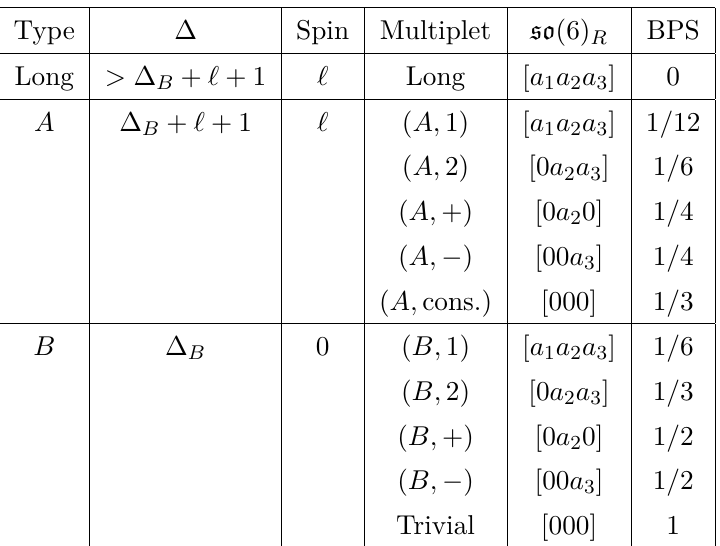
Table 2 . Multiplets of osp (6 | 4) and the quantum numbers of their superconformal primary, where ∆ B = a 1 + 1 ( a 2 + a 3 ) 2